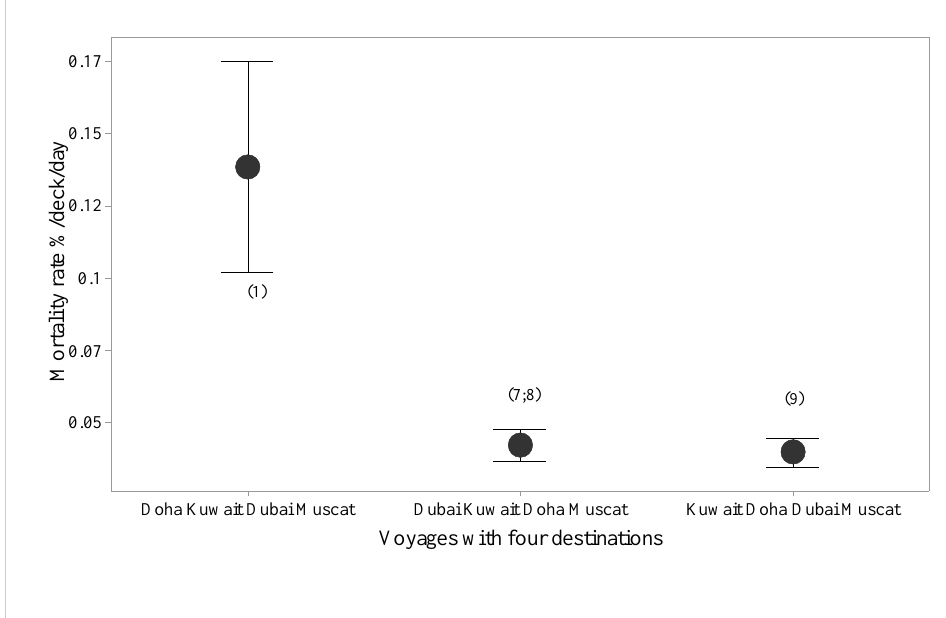
Figure 6. Mortality rate (%/deck/day with standard deviations) for voyages ( n = 6, voyage numbers in parentheses) with three destination ports in different orders.